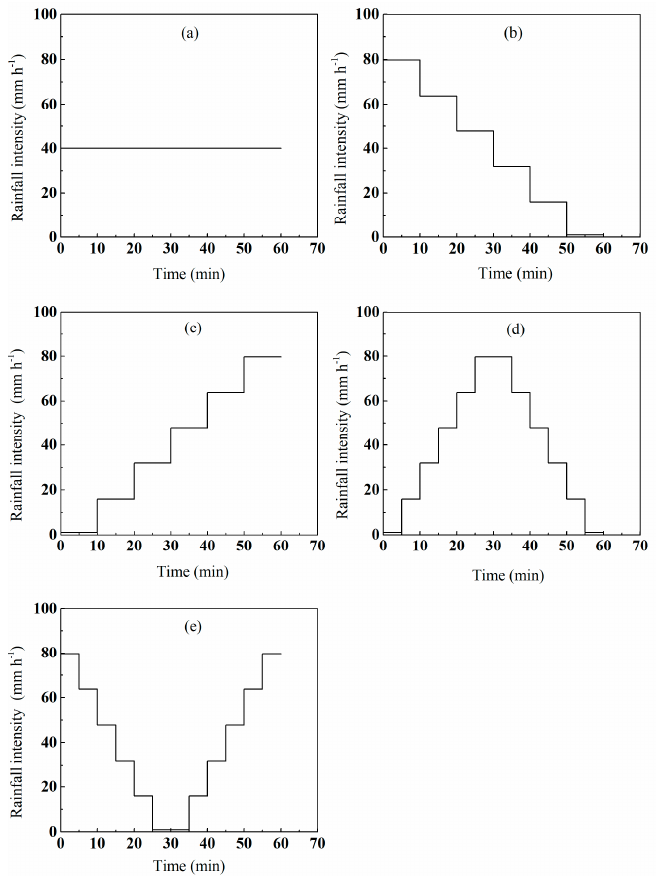
Figure 2. Five different rainfall patterns. ( a ) constant, ( b ) decreasing, ( c ) increasing, ( d ) rising-falling and ( e ) falling-rising.